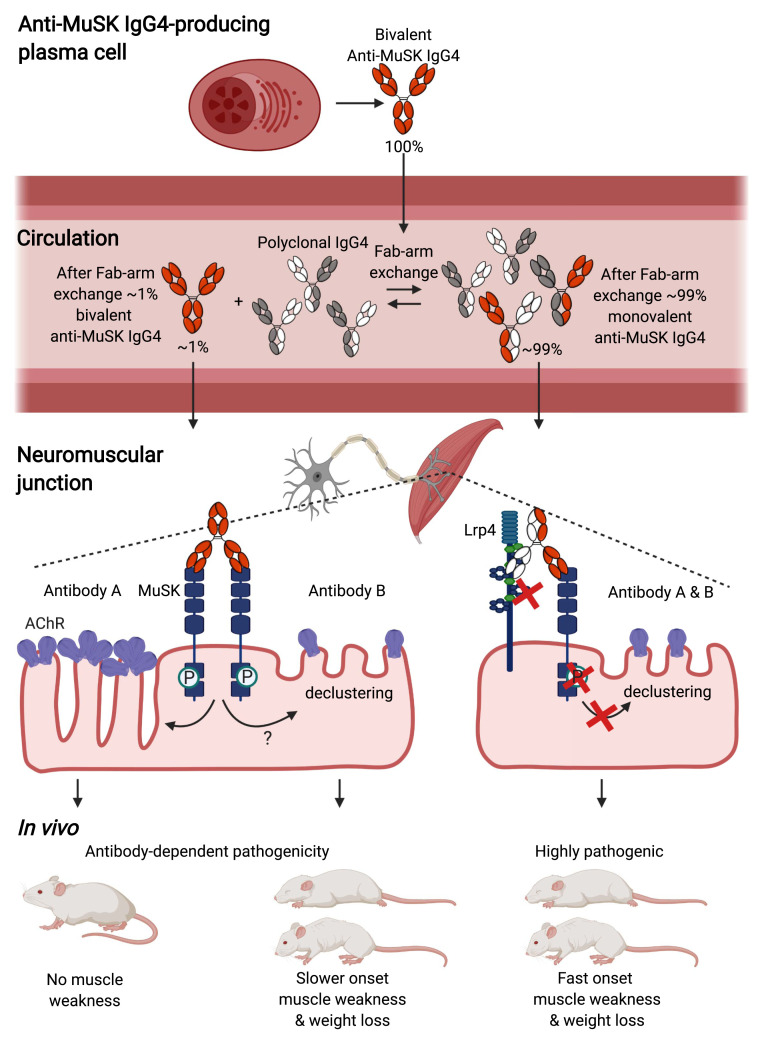
Functional monovalency amplifies the pathogenicity of anti-MuSK IgG4. Anti-MuSK IgG4 is produced as monospecific bivalent antibody. Upon reaching the circulation, Fab-arm exchange renders ∼99% of IgG4 MuSK antibodies bispecific and functionally monovalent. Monovalent MuSK antibodies reach NMJs and, upon binding to MuSK, block its function and induce AChR declustering, resulting in fast-onset progressive myasthenia. Monospecific functionally bivalent MuSK antibodies dimerize and activate MuSK signaling independent of agrin. Depending on the clone, this direct effect on MuSK either results in more slowly progressing myasthenia due to depletion of AChRs, by a yet-to-be-discovered mechanism, or induces no clinical phenotype with largely intact NMJs. P: phosphorylation. This figure was created with BioRender.com.